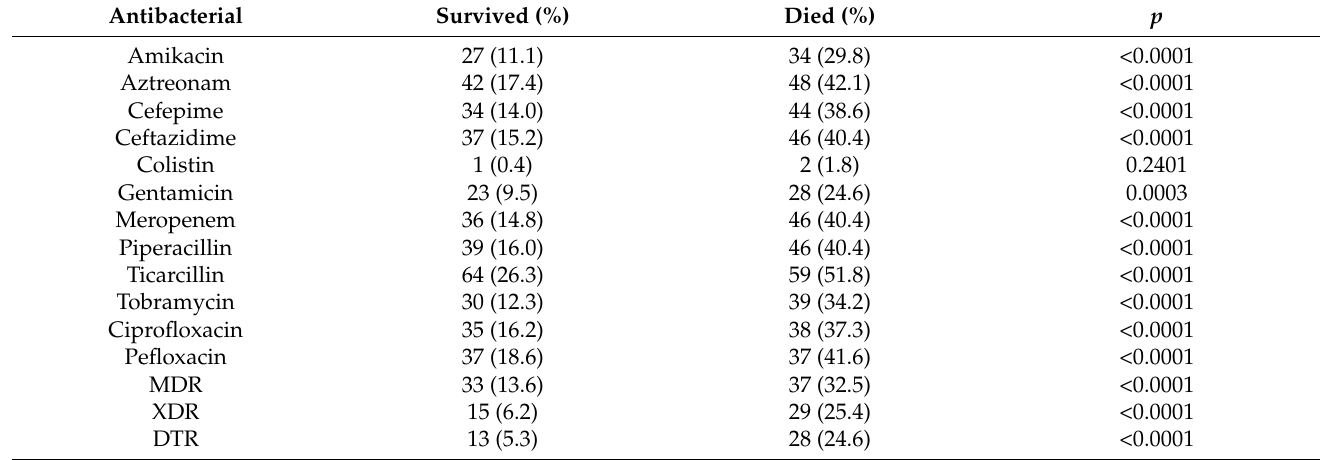
Table 5. Antimicrobial resistance of Pseudomonas aeruginosa strains isolated from patients’ blood cultures compared to patients’ outcome at 30 days after the occurrence of